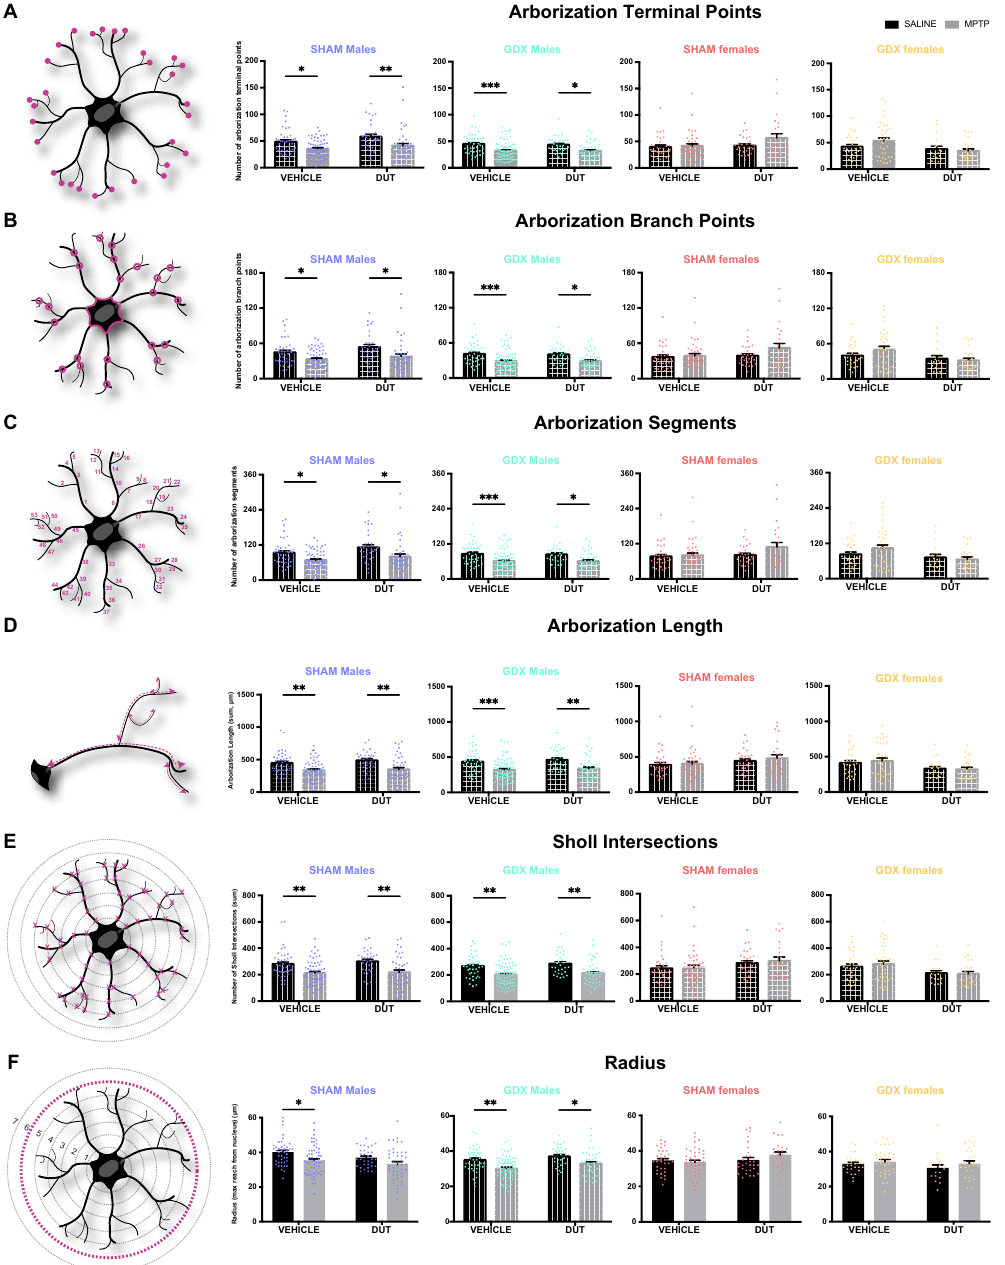
Figure 4. Three-dimension morphological analysis of striatal microglia schematic and effect of